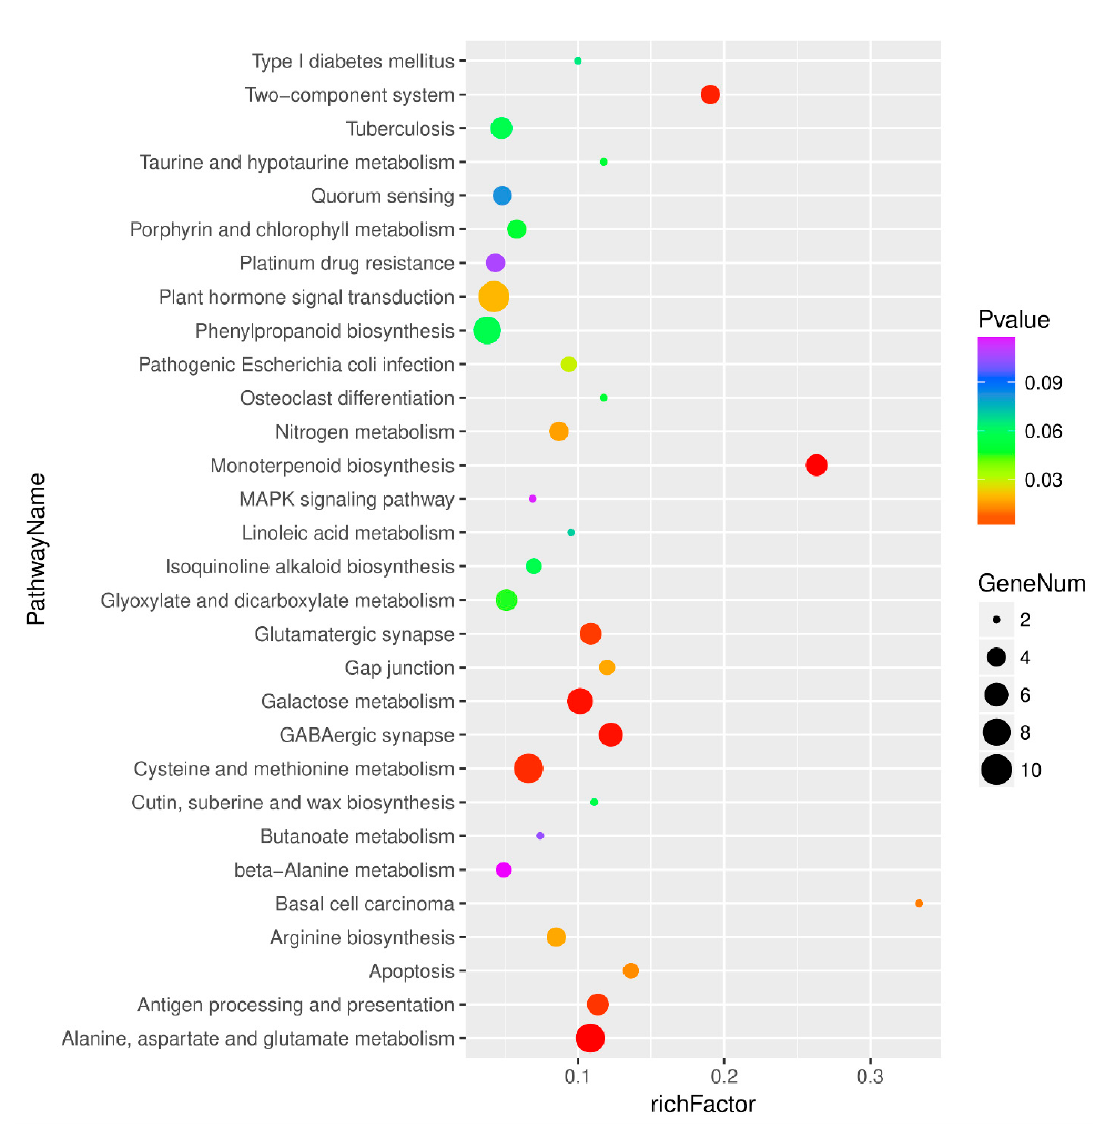
Figure 6. Kyoto Encyclopedia of Genes and Genomes (KEGG) Pathway enrichment analysis of DEGs identified. KEGG Pathway enrichment analysis based on the differentially up-regulated genes between VFSP and VCSP ( A ) leaves and ( B ) storage roots. KEGG Pathway enrichment analysis based on the differentially down-regulated genes between VFSP and VCSP ( C ) leaves and ( D ) storage roots.